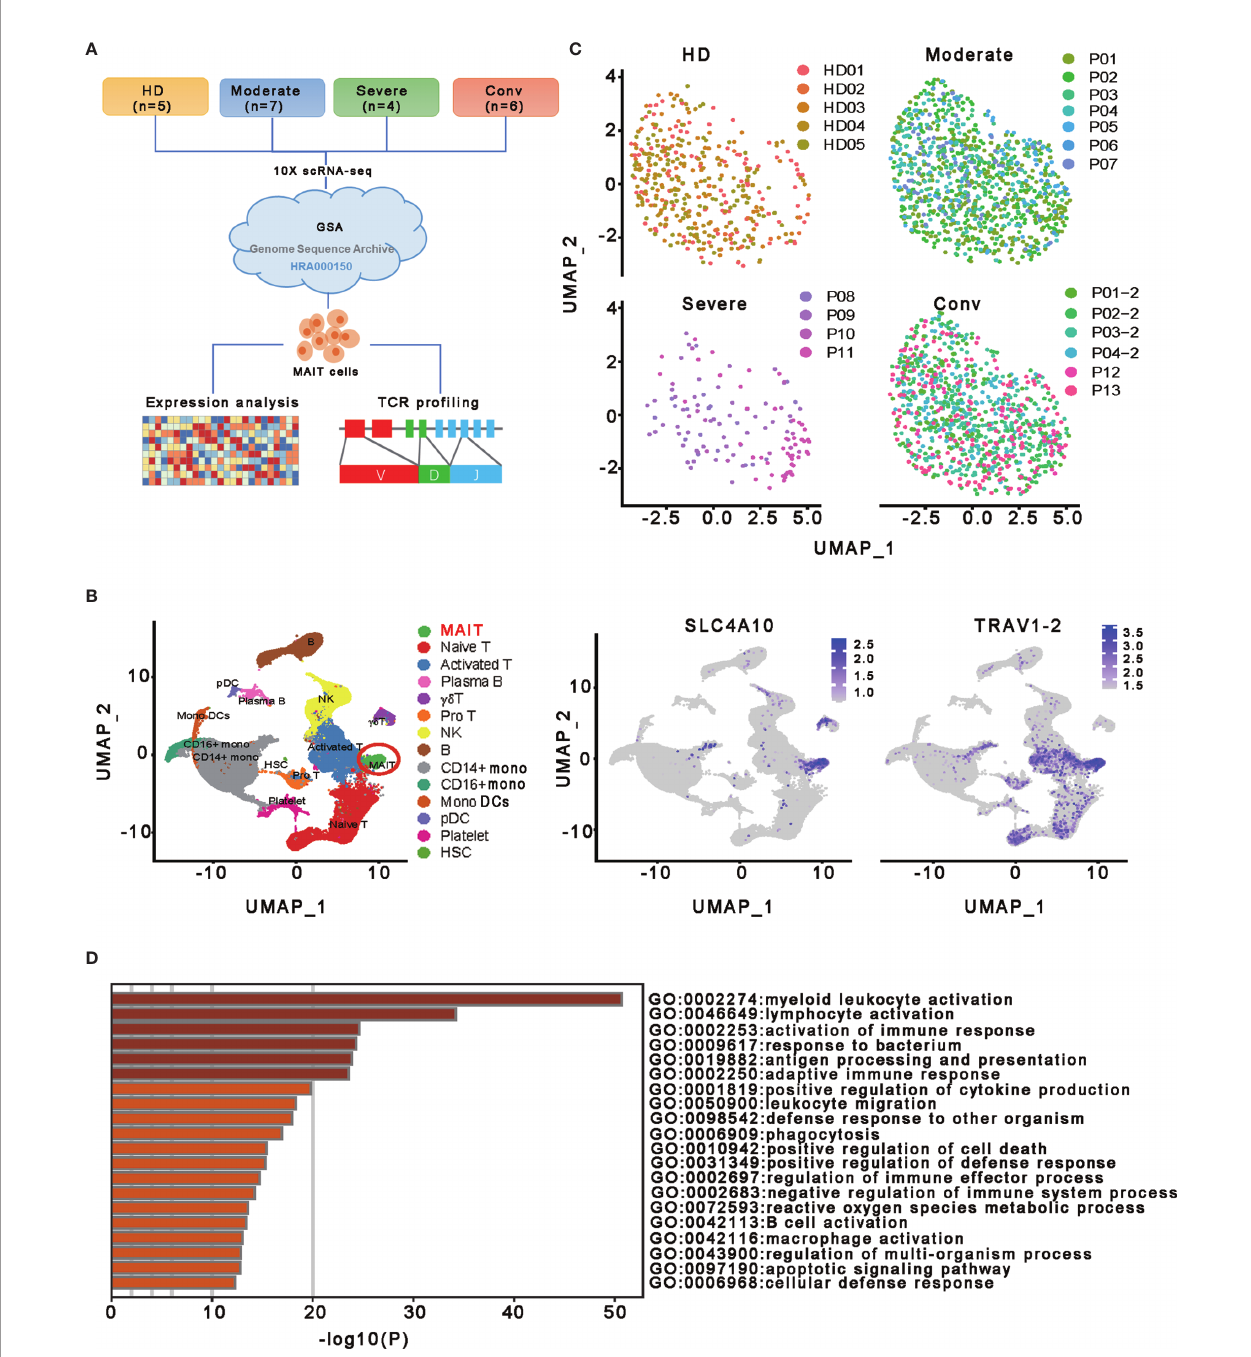
FIGURE 1 | Single-cell gene expression pro fi ling of MAIT cells derived from PBMCs of the participants. (A) Schematic diagram of this study design. The scRNA − seq data for MAIT cells were processed for expression analysis and TCR pro fi ling across four conditions, including HD (n = 5), moderate (n = 7), severe (n = 4) and conv (n = 6). (B) UMAP projection of integrated single-cell transcriptomes of 121464 cells from all participants (left) and MAIT cell annotation (right). The left scatter plot shows all 14 cell types and each dot represents a single cell, colored according to cell type. MAIT cells are circled in red. The right two scatter plots show the expression of canonical markers of MAIT cells and the cell are colored according to the expression level. (C) UMAP representations of MAIT cells in HD, moderate, severe, and conv conditions, respectively. Cells are color-coded by individual samples, respectively. (D) Gene enrichment analyses of the DEGs in the MAIT cells in comparison with 13 other immune cell types (naïve T cell, activated T cells, gd T cells, proliferative T cells, natural killer cells, B cells, plasma B cells, CD14+ monocytes, CD16+ monocytes, monocyte-derived dendritic cells, plasmacytoid dendritic cells, platelets, and hemopoietic stem cells) in